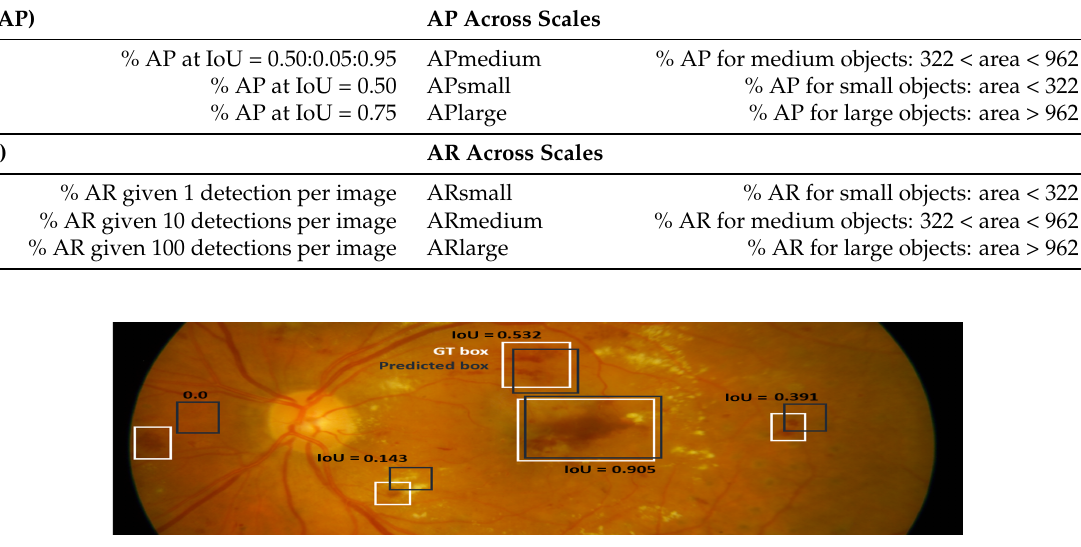
Figure 5. Example IoU scores for the detected bounding